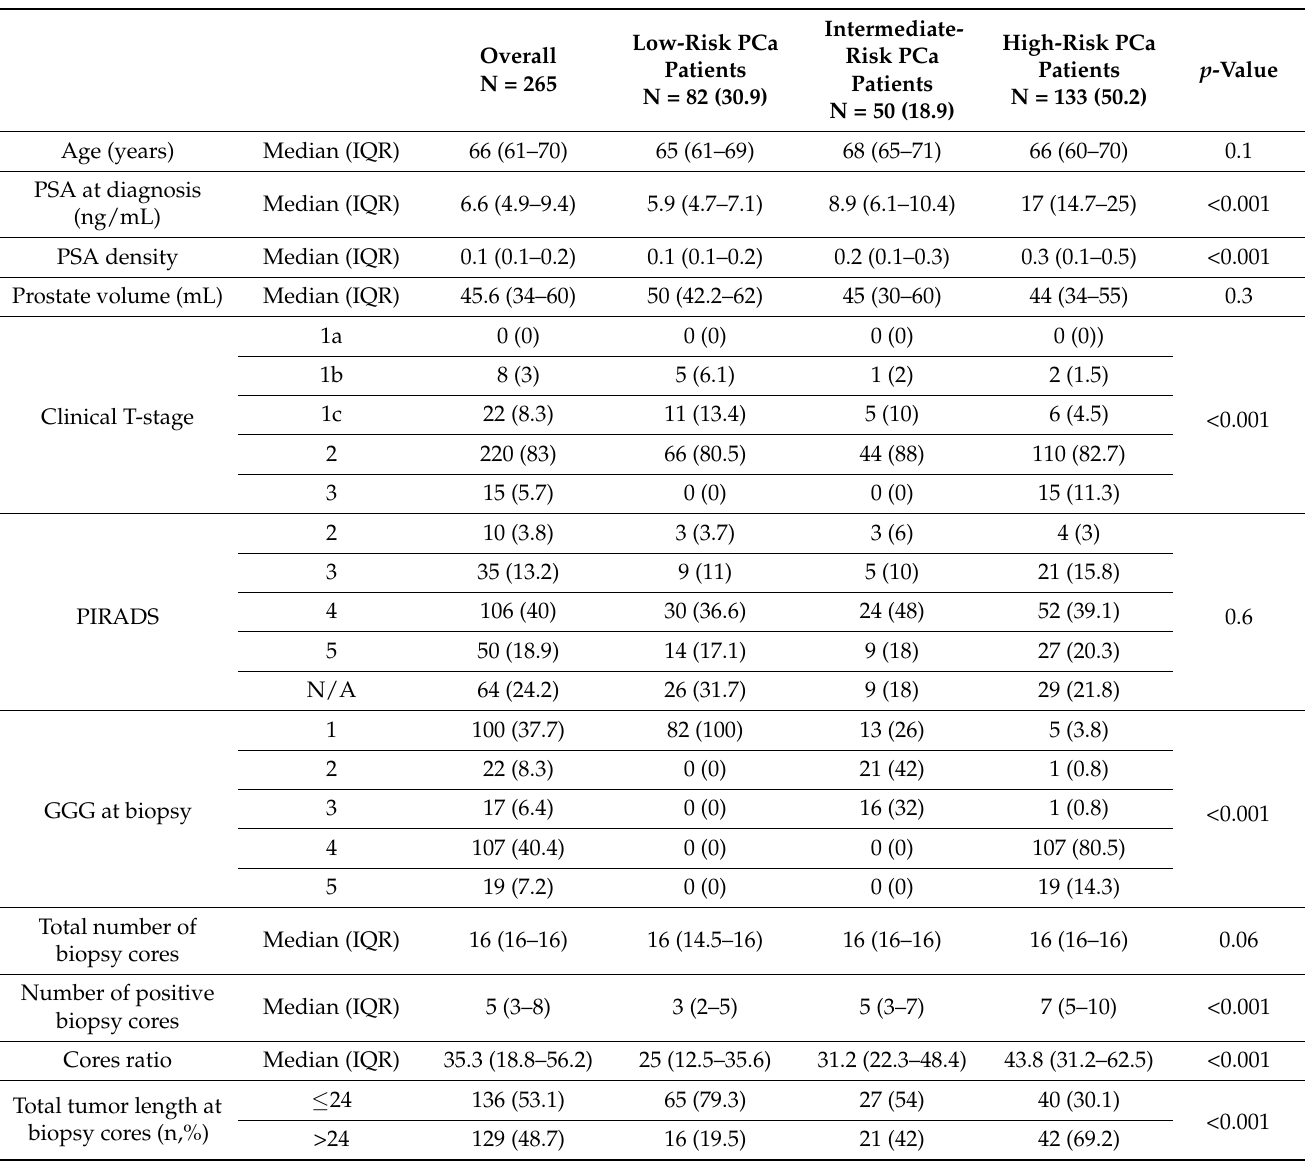
Table 1. Baseline characteristics of 265 PCa patients stratified according to D’Amico risk classification. “Core ratio” is defined as the ratio between the number of positive biopsy cores and of obtained biopsy